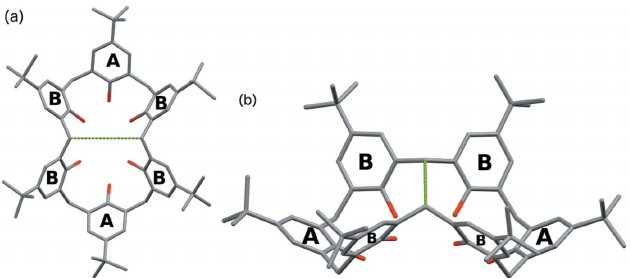
Figure 2 ( a ) Top and ( b ) side views of the TBC6 molecular structure in the pinched-cone conformation, showing the A - and B -type phenyl rings and definition of the S distance (green lines). The hydrogen atoms have been removed for clarity.